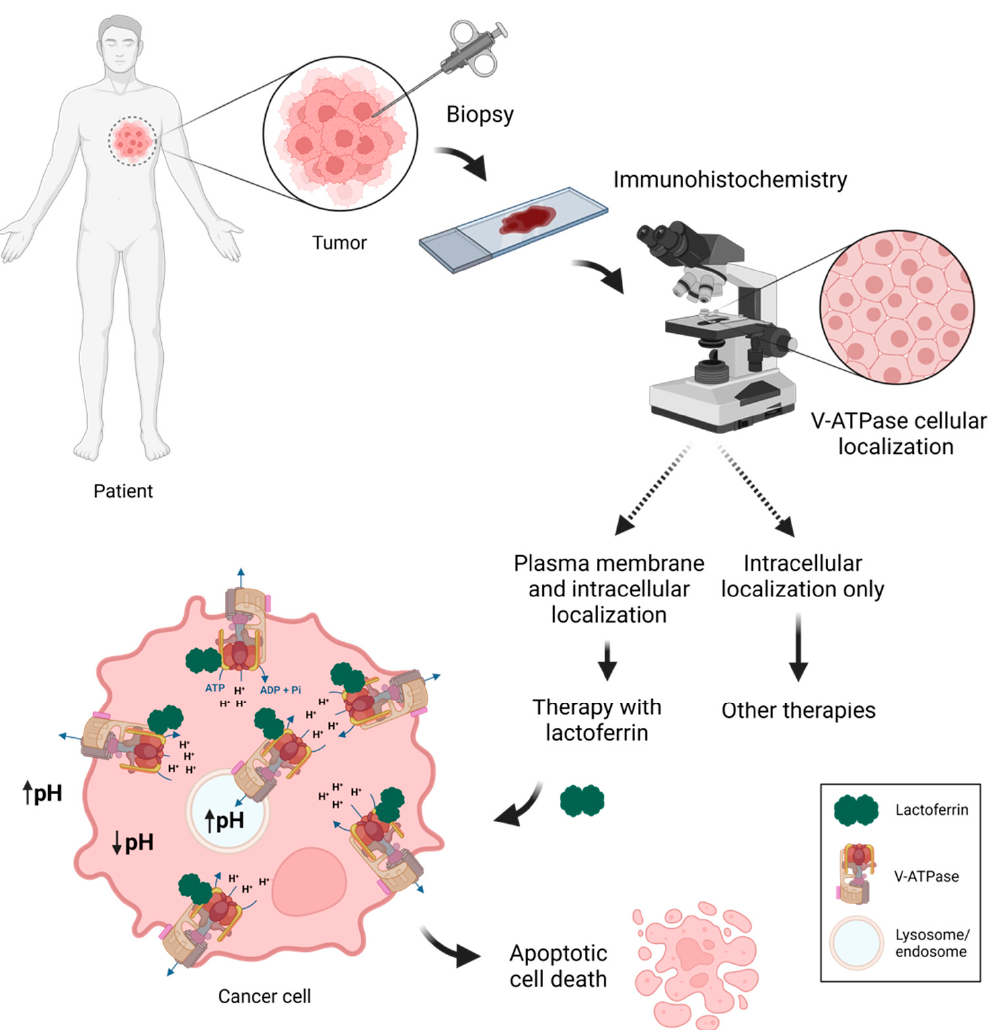
Figure 1. Plasmalemmal V-ATPase as a potential biomarker for guiding treatment decisions regarding Lf-based anticancer strategies. Tumor biopsies followed by immunohistochemistry with anti-V-ATPase antibodies would allow determining V-ATPase cellular localization. If it is at the plasma membrane, then Lf treatment would be effective as the protein would inhibit V-ATPase causing intracellular acidification and extracellular and lysosomal alkalinization, ultimately leading to apoptotic cell death of cancer cells. If V-ATPase is only localized intracellularly, then Lf treatment would not be successful and other therapeutic interventions should be considered. Created with BioRender.com.